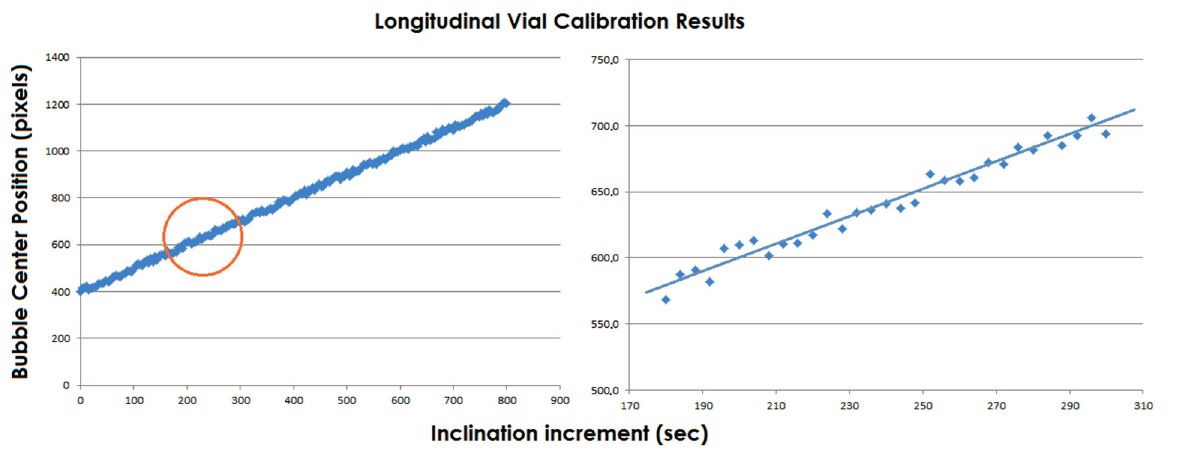
Figure 11. ( Left ) The results of the calibration; ( Right ) The enlargement of the circled zone and the interpolating line.